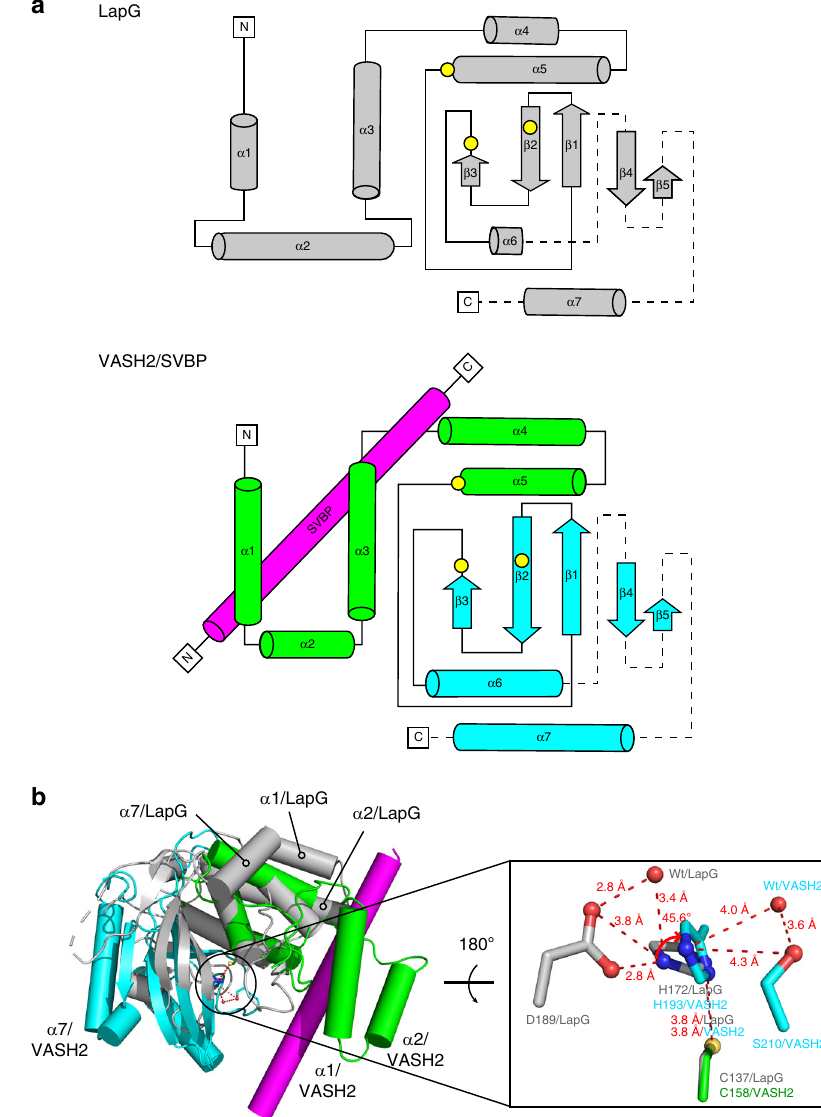
Fig. 2 Structural comparison between LapG and VASH2. a Secondary structure and topological diagrams of the two cysteine proteases. LapG is colored gray, NTD and CTD of VASH2 are colored green and cyan, and SVBP is colored magenta, respectively. The residues positions of the catalytic triad are highlighted in yellow circles. b LapG (PDB ID: 4FGP) is aligned to VASH2 using the catalytic cysteine (C137 in LapG and C158 in VASH2). Structures are colored in the same scheme in ( a ). The pocket of the catalytic triad is zoomed-in with residues shown in stick representation. Two water molecules in the pocket are shown as red spheres. The red arrow indicates a 45.7° rotation of the imidazole